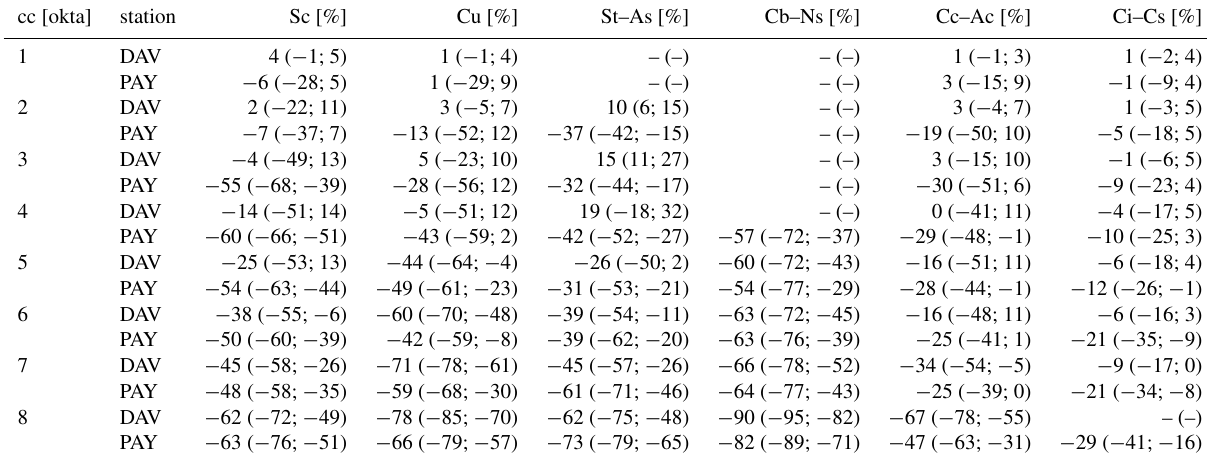
Table 2. Median and interquartile range of relative shortwave cloud radiative effect values [%] per okta for the two stations Davos (DAV) and Payerne (PAY) and six cloud classes stratocumulus (Sc), cumulus (Cu), stratus–altostratus (St–As), cumulonimbus–nimbostratus